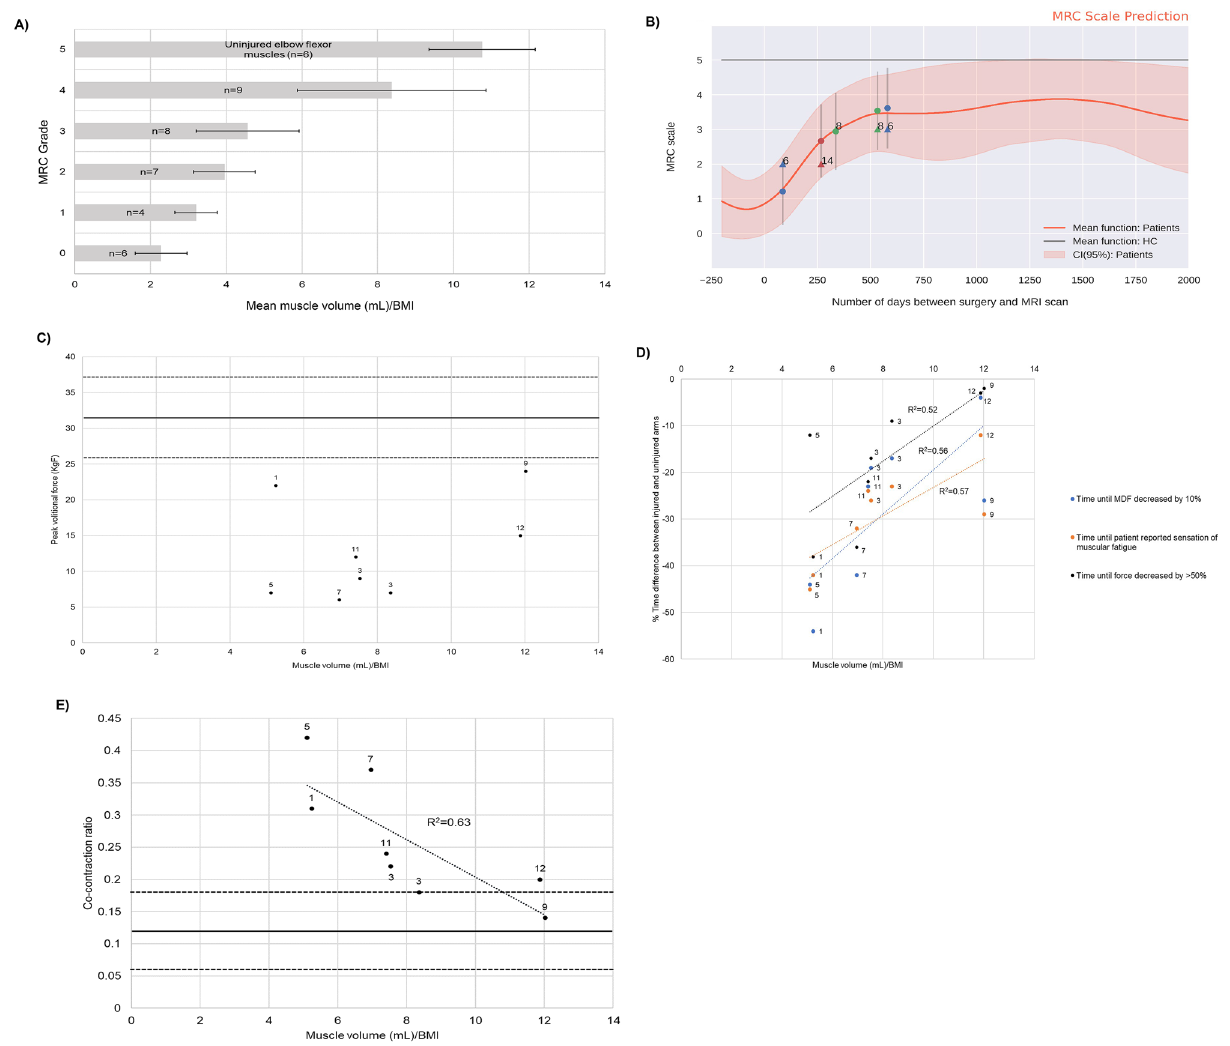
Figure 2. Relationship between muscle volume per unit BMI and objective measurements of muscular function. The error bars in ( A) represent one standard deviation from the mean. In ( B–E) case numbers are attached in reference to Additional file 1 which also provides details pertaining to the time interval between injury and surgery as well as surgery and clinical assessments. In ( C, E), the solid black line represents the mean PVF and co-contraction ratio obtained from the uninjured contralateral arms respectively whilst the dashed lines represent one standard deviation from the mean. ( A) An MRC grade of 0, 1, 2, 3 and 4 was associated with a mean reinnervated muscle volume per unit BMI of 2.28 (± 0.7), 3.20 (± 0.56), 3.96 (± 0.81), 4.57 (± 1.36) and 8.37 (± 2.49) respectively. Uninjured muscles (MRC grade 5) had a mean muscle volume per unit BMI of 10.76 (± 1.42). There was a statistically significant difference in muscle volume per unit BMI between MRC grade 4 and 0, 5 and 0, 4 and 1, 5 and 1, 4 and 2, 5 and 2, 4 and 3 as well as 5 and 3 as assessed by a one-way analysis of variance (ANOVA) and Bonferroni test. ( B) Application of a Hierarchical Gaussian Process model to the data presented in ( A). The circular data points represent the predicted values on the triangular points denote the actual data points. ( C) The relationship between PVF and muscle volume (mL) per unit BMI. ( D) The relationship between sEMG, force and subjective measurements of muscular fatigue and muscle volume (mL) per unit BMI. (E) The relationship between co-contraction and muscle volume (mL) per unit